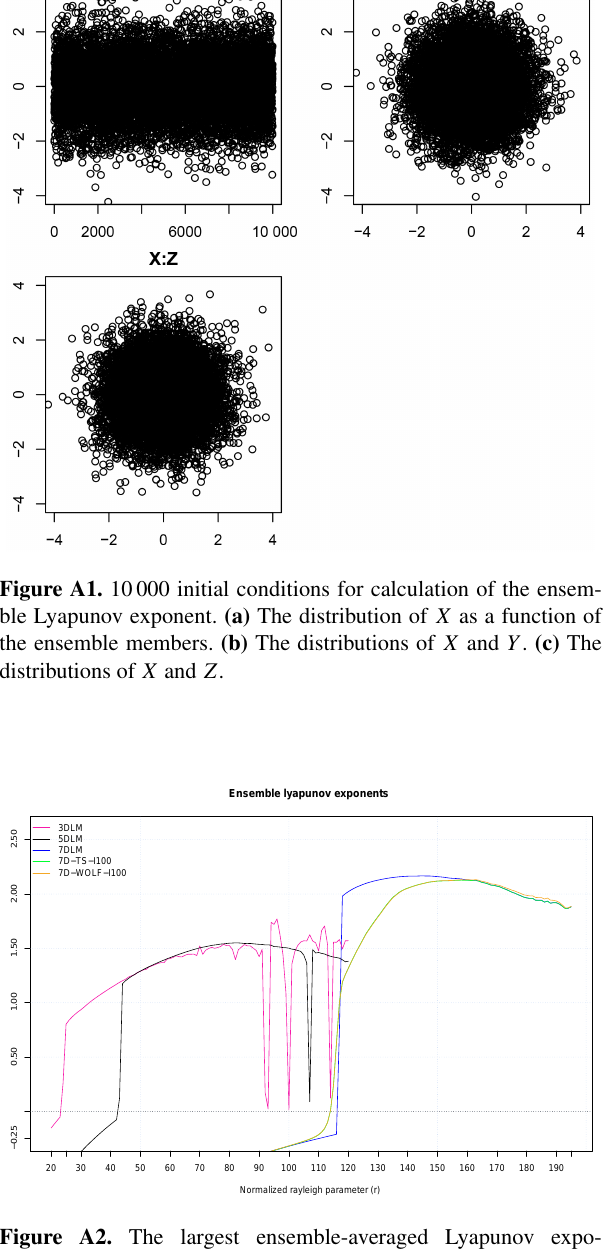
Figure A2. The largest ensemble-averaged Lyapunov expo- nents (eLEs) as a function of the forcing parameter, r , in differ- ent LMs. The figure provides results for (cid:49)r = 1. The pink, black, and blue lines display eLEs for the 3DLM, 5DLM, and 7DLM, re- spectively, using the TS method. Two parallel experiments using the 7DLM with ICs that are 100 times that of the ICs in the control run are shown with green and orange lines. The first one applies to the TS method, while the second uses the GSR method. Note that the critical value of r for the onset of chaos in the 7DLM with different ICs are